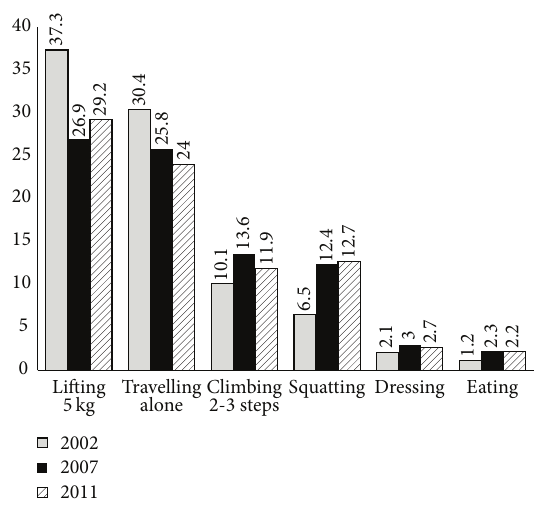
Figure 1: Weighted prevalence (percent) of the six studied disabili- ties by year.